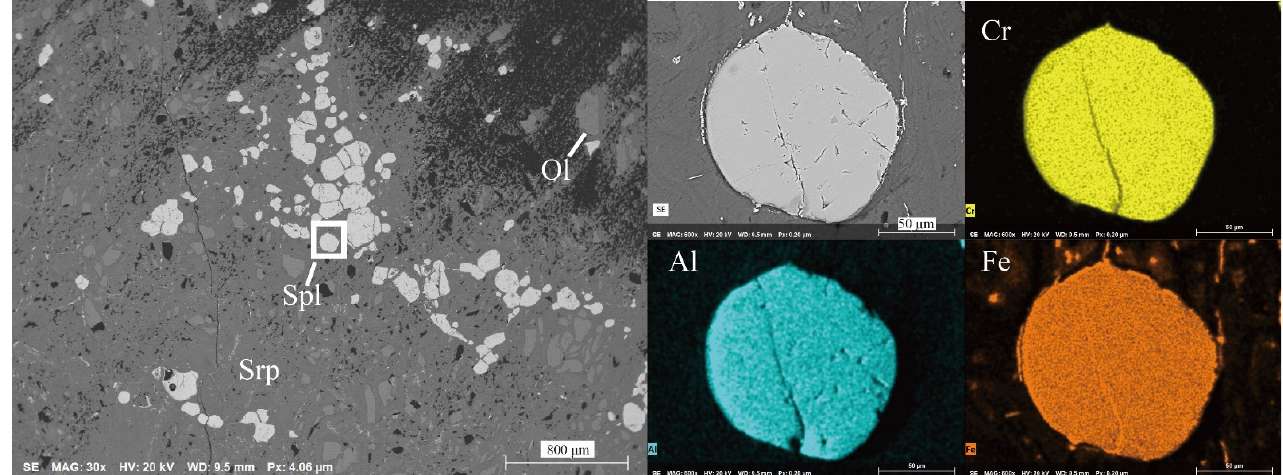
Figure 4. BSE images and multi-element mapping images of type A Cr-spinel in dunite. Type A spinel is subhedral in shape and homogeneous in